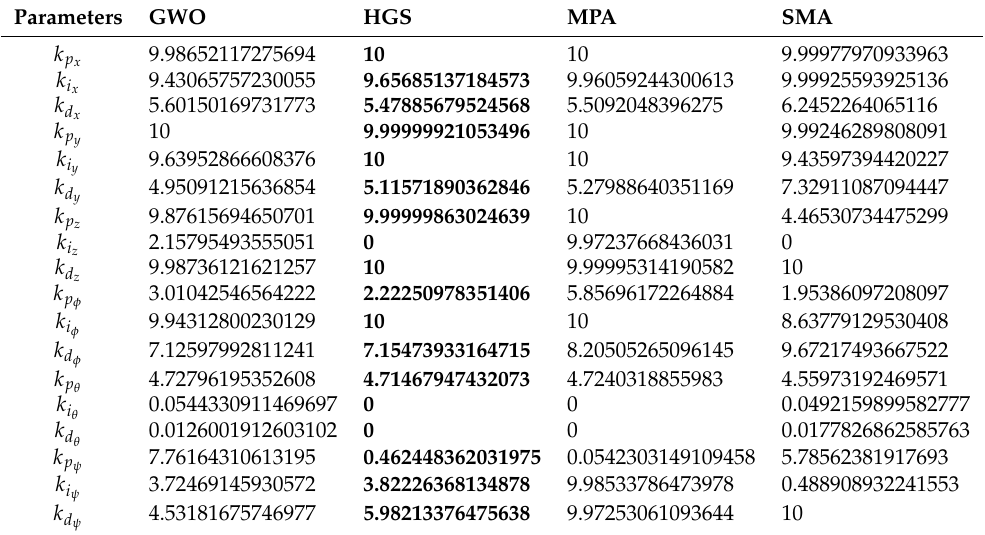
Table 8. The parameter estimation of metaheuristic algorithms with 80 individuals, 40 evolutions and 30 repetitions.